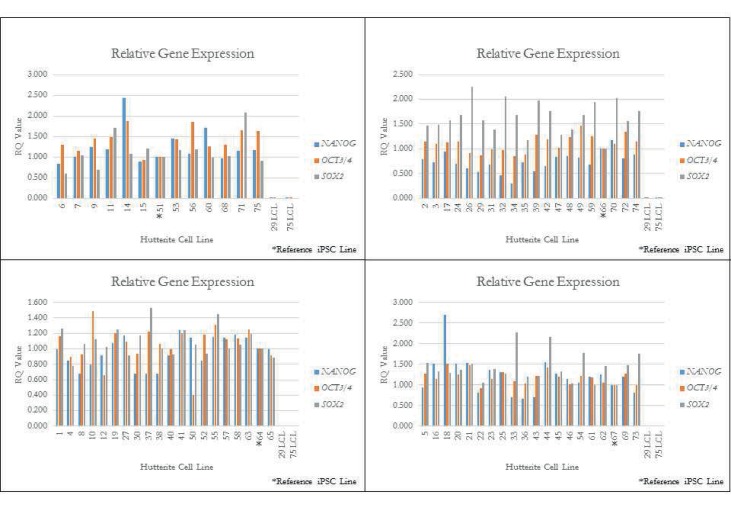
qPCR for key pluripotency genes for a subset of iPSCs.qPCR quality control of iPSC lines. Quantitative PCR (qPCR) of pluripotency genes OCT3/4, NANOG, and SOX2 on randomly selected Hutterite iPSC lines (denoted by *). Relative expression is the RQ value with respect to GAPDH expression, with error bars representing the calculated min and max RQ value. All iPSC lines show endogenous expression of these pluripotency genes. Two original LCL lines are included as control and show little or no expression of pluripotency genes.